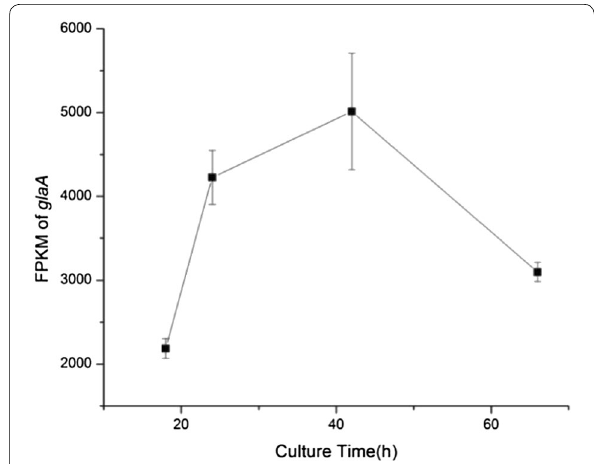
Fig. 4 Gene expression of glaA encoding glucoamylase during fermentation. All FPKM of genes were calculated based on triplicate biological samples and the error bar means the error among three biological replicate samples